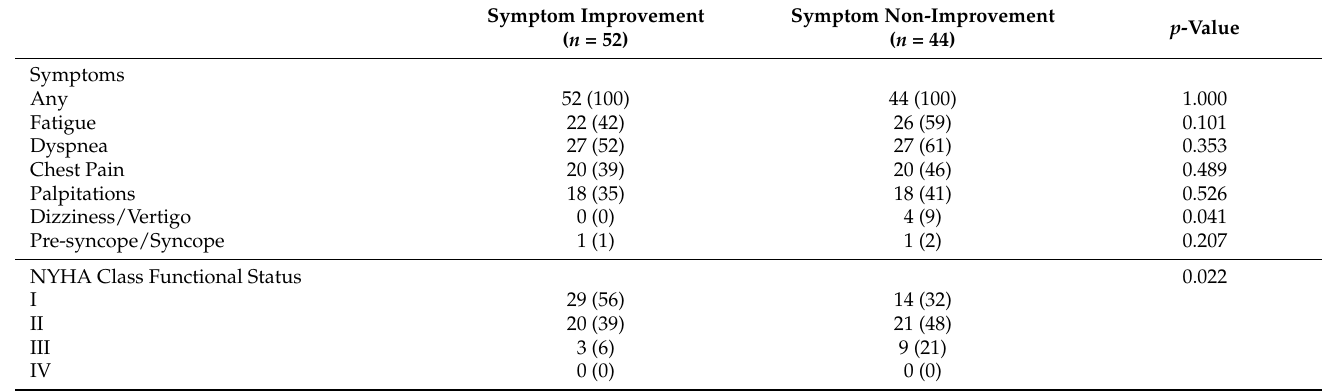
Table 8. Long-COVID symptoms and objective findings according to symptomatic